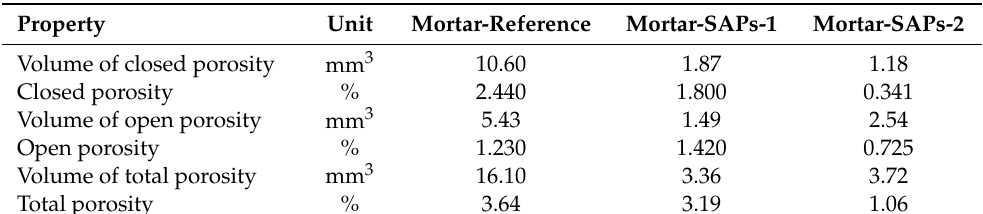
Table 3. Statistical pore analysis of mortar specimens.